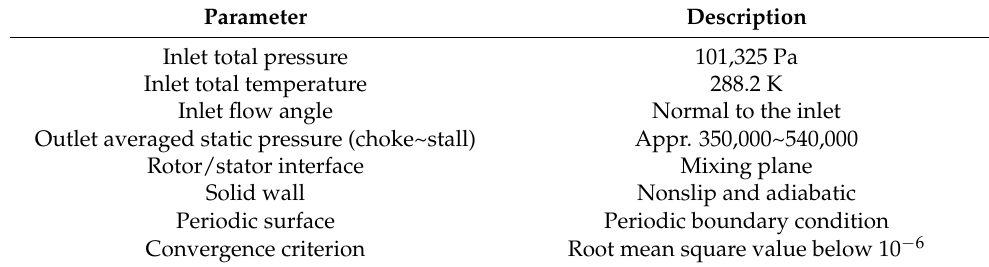
21 Table 4. Summary of grid numbers and discretization errors.